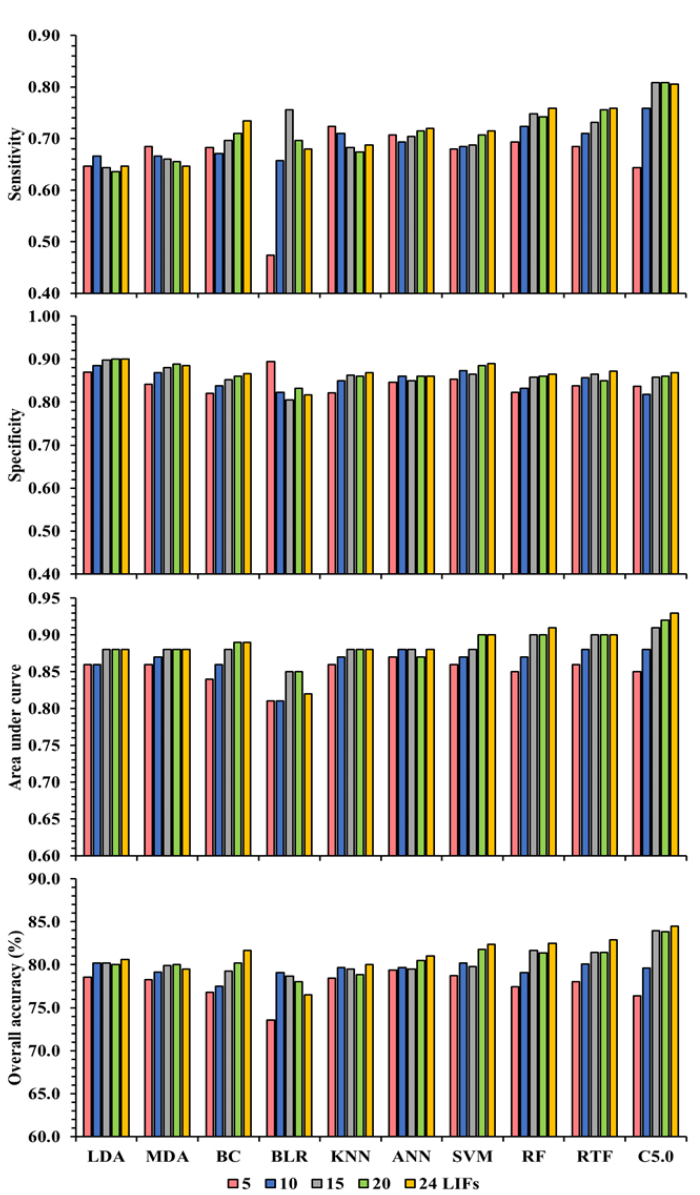
Figure 9. Accuracy statistics of ML models for LSM using different sets of LIFs. Different ML models showed different responses to the number of LIFs used in model development. Among all developed ML models, the ANN and KNN achieved the maximum sensitivity value (i.e., 0.71–0.72) with the top 5 LIFs. The sensitivity values of KNN and MDA decreased by 0.03 when the number of LIFs increased. The LDA produced similar sensitivity values for all numbers of LIFs, except 10 LIFs (where sensitivity was slightly maximized). The BLR showed the worst performance (relative to other ML models) when developed using the top 5 LIFs. The BC, SVM, RF, and RTF showed a slight improvement (3–8%) in their sensitivity values when developed using all LIFs. The C5.0 yielded the lowest sensitivity value (i.e., 0.64) (except BLR) using the top 5 LIFs but outperformed other models when developed using ≥ 15 LIFs. The top seven performing models (C5.0, KNN, ANN, RTF, RF, SVM, and BC) were considered in developing the ensemble ML models.